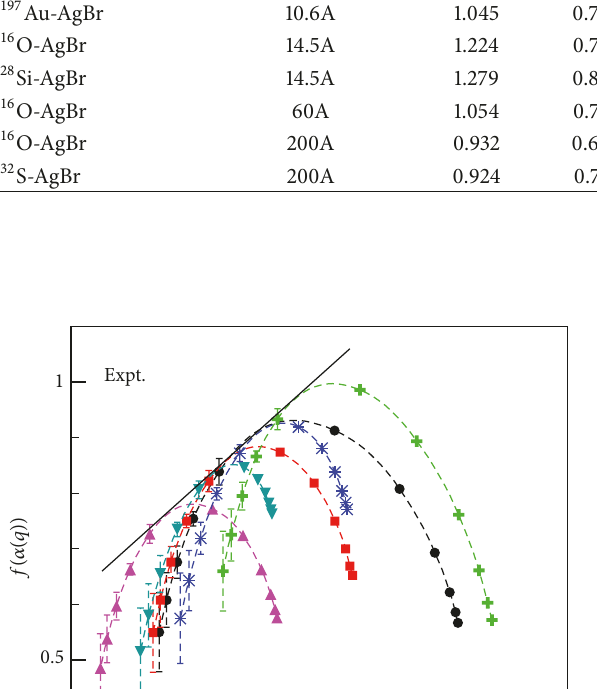
Table 3: Values of width ( 𝛼 max − 𝛼 min ) of 𝑓(𝛼(𝑞)) spectrum for the various event samples. Type of interactions